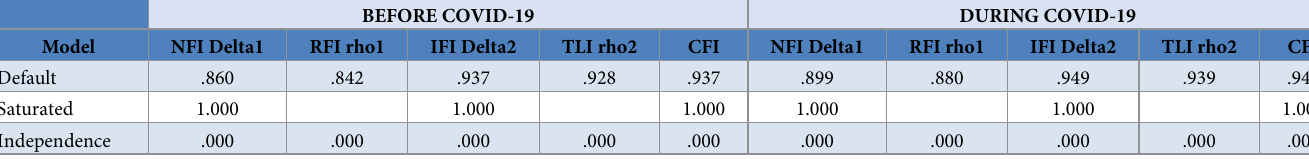
Table 3. Baseline comparisons.